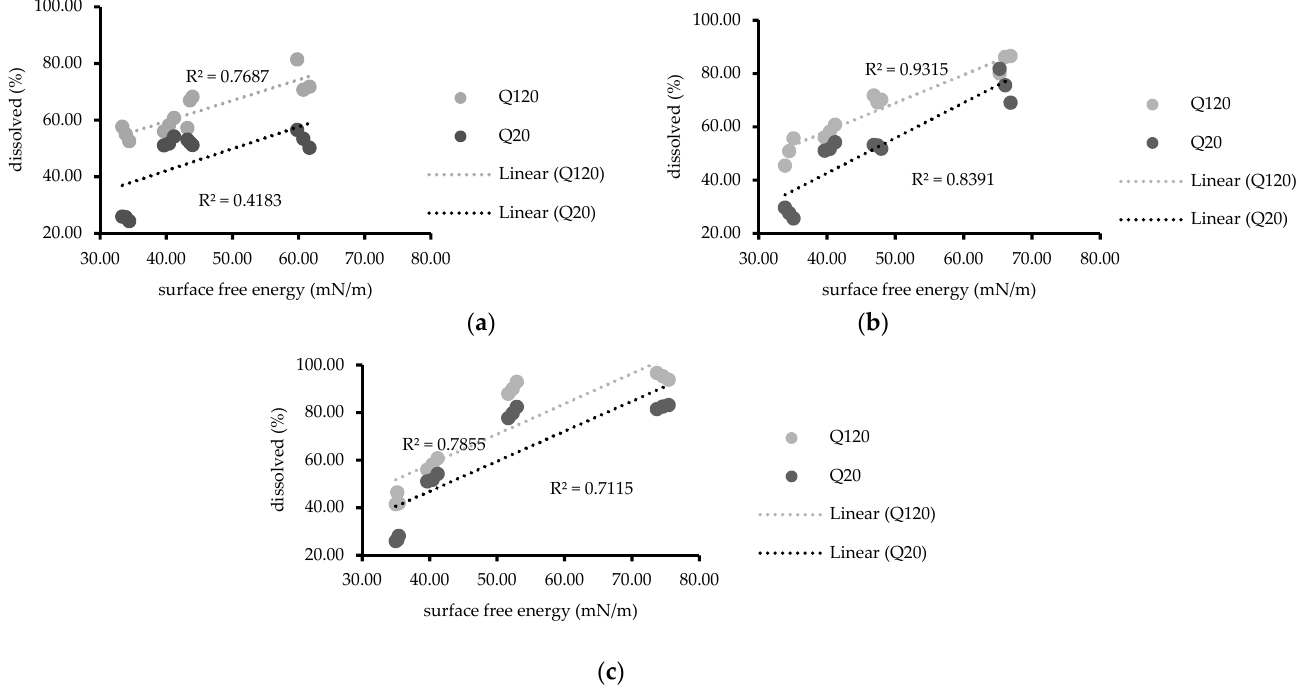
Figure 6. Relationship between surface free energy and percentages of drug dissolved (20 and 120 min) at polysorbate concentrations of ( a ) 0.1%, ( b ) 0.3%, and ( c ) 0.6%.